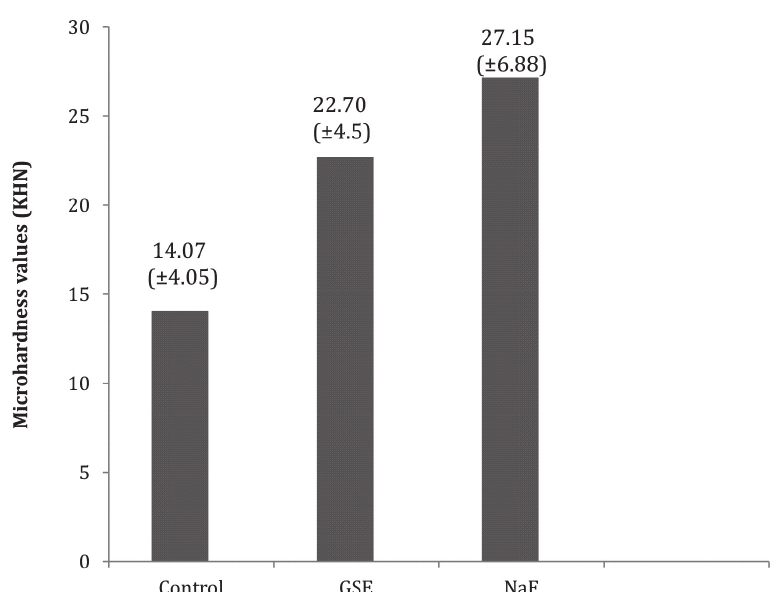
Figure 6- Means and standard deviation of dentin cross-sectional hardness (KHN) according to the different groups after treatment with fluorides and grape seed extract